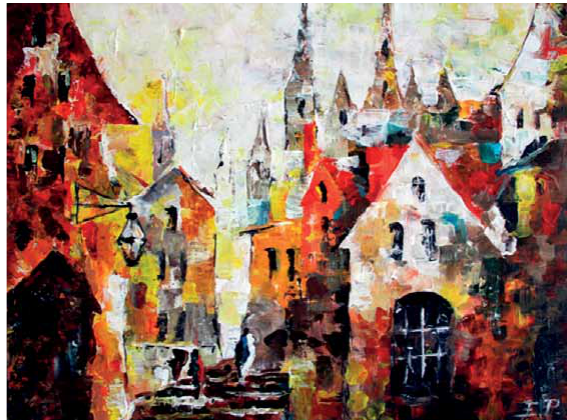
fig. 2. Model is an obligatory part of each